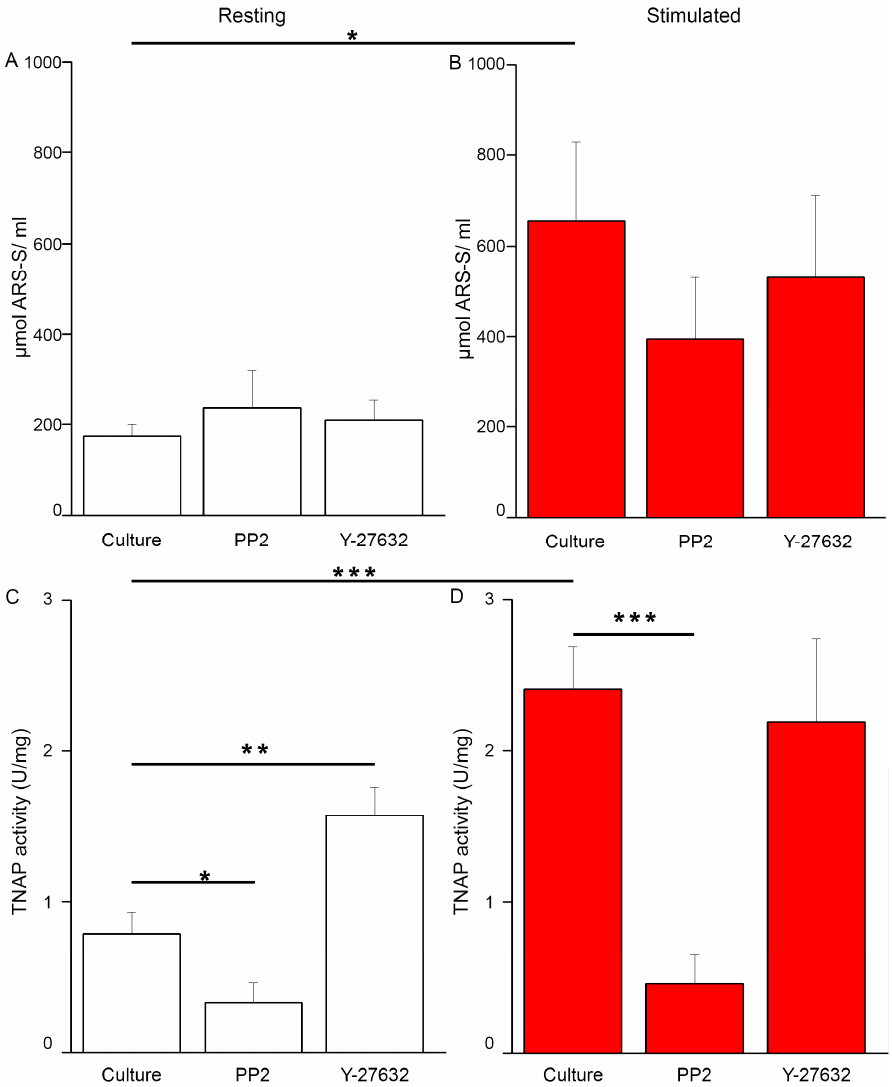
Figure 2. ( A , B ) Mineralization level of Saos-2 cells, non-treated or treated with di ff erent inhibitors, in resting conditions ( A ) or after seven-day stimulation with AA and β -GP ( B ). Both panels ( A , B ) are labeled uniformly: untreated cells (Culture) or cells incubated with di ff erent inhibitors: 20 µ M of PP2 or 20 µ M of Y-27632. Ca salts were stained with Alizarin Red-S (AR-S) and dissolved in cetylpyridinium chloride (CPC), and their content was measured spectrophotometrically at λ 562 nm, n = 6, * p < 0.05. ( C , D ) Tissue non-specific alkaline phosphatase (TNAP) activity in Saos-2 cells in resting conditions ( C ) or after stimulation with AA and β -GP ( D ). Cells were either non-treated or treated with di ff erent inhibitors. Both panels ( C , D ) are labeled uniformly: untreated cells (Culture) or cells incubated with di ff erent inhibitors: 20 µ M of PP2 or 20 µ M of Y-27632. TNAP activity was measured using ALP Yellow pNPP Liquid Substrate System for ELISA (Sigma, Saint Louis, MO, USA), and the absorbance was recorded spectrophotometrically at λ 405 nm, n = 3, * p < 0.05, ** p < 0.01, *** p <